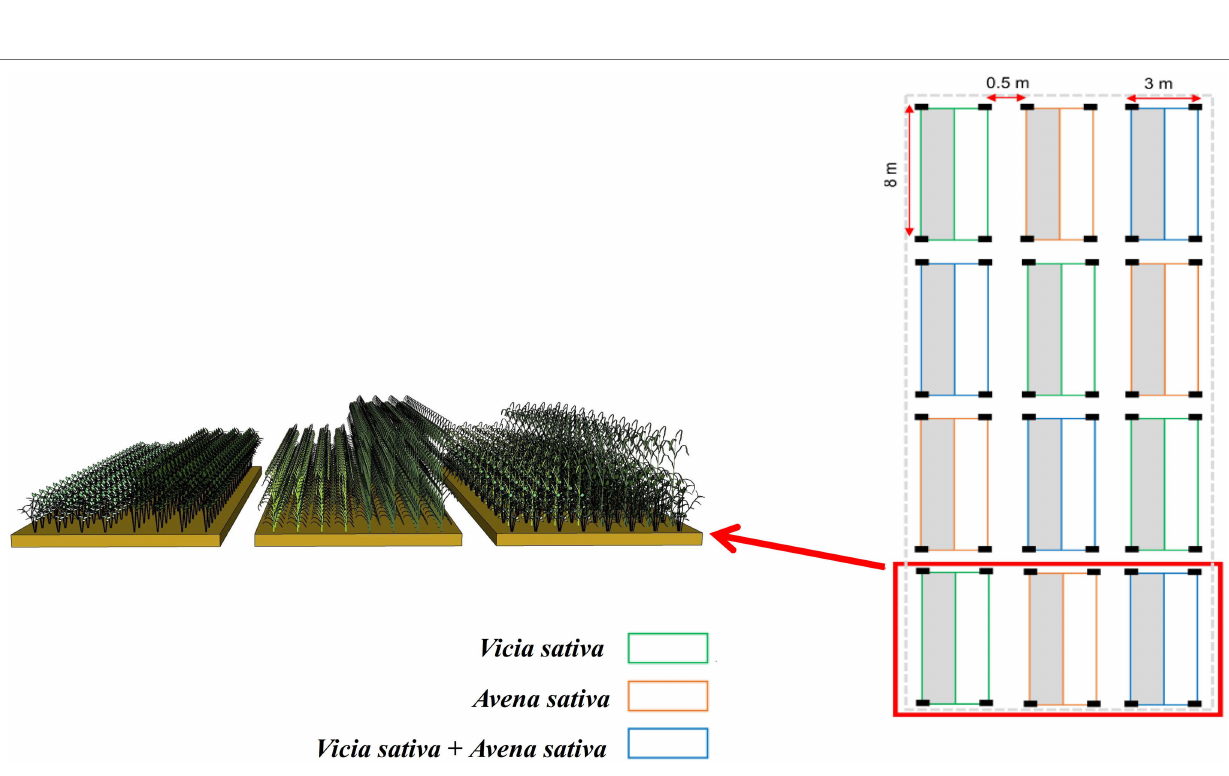
FIGURE 3 | Layout of field experimental design. Left half in gray represents simulated grazing treatment; right half in white represents harvesting hay